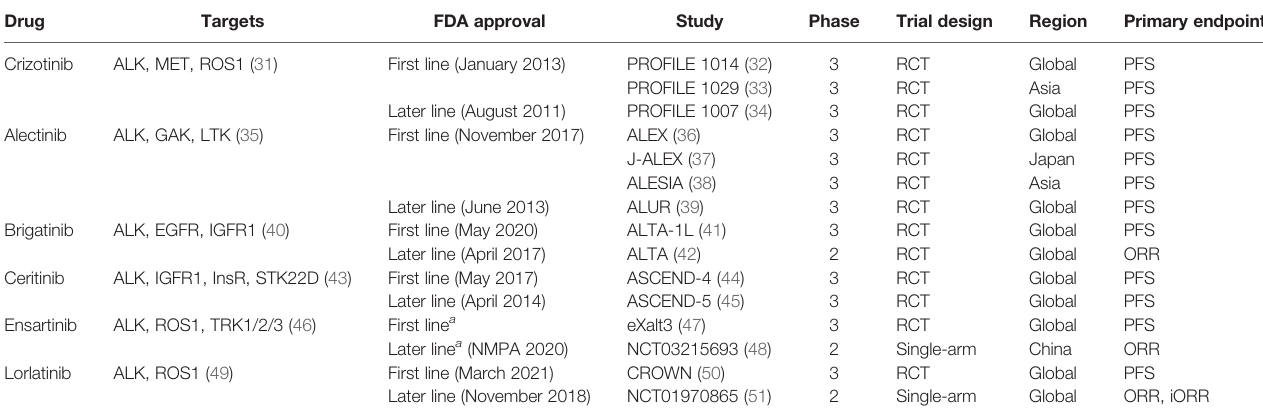
TABLE 1 | Pivotal clinical trials of currently approved ALK TKIs in NSCLC. Drug